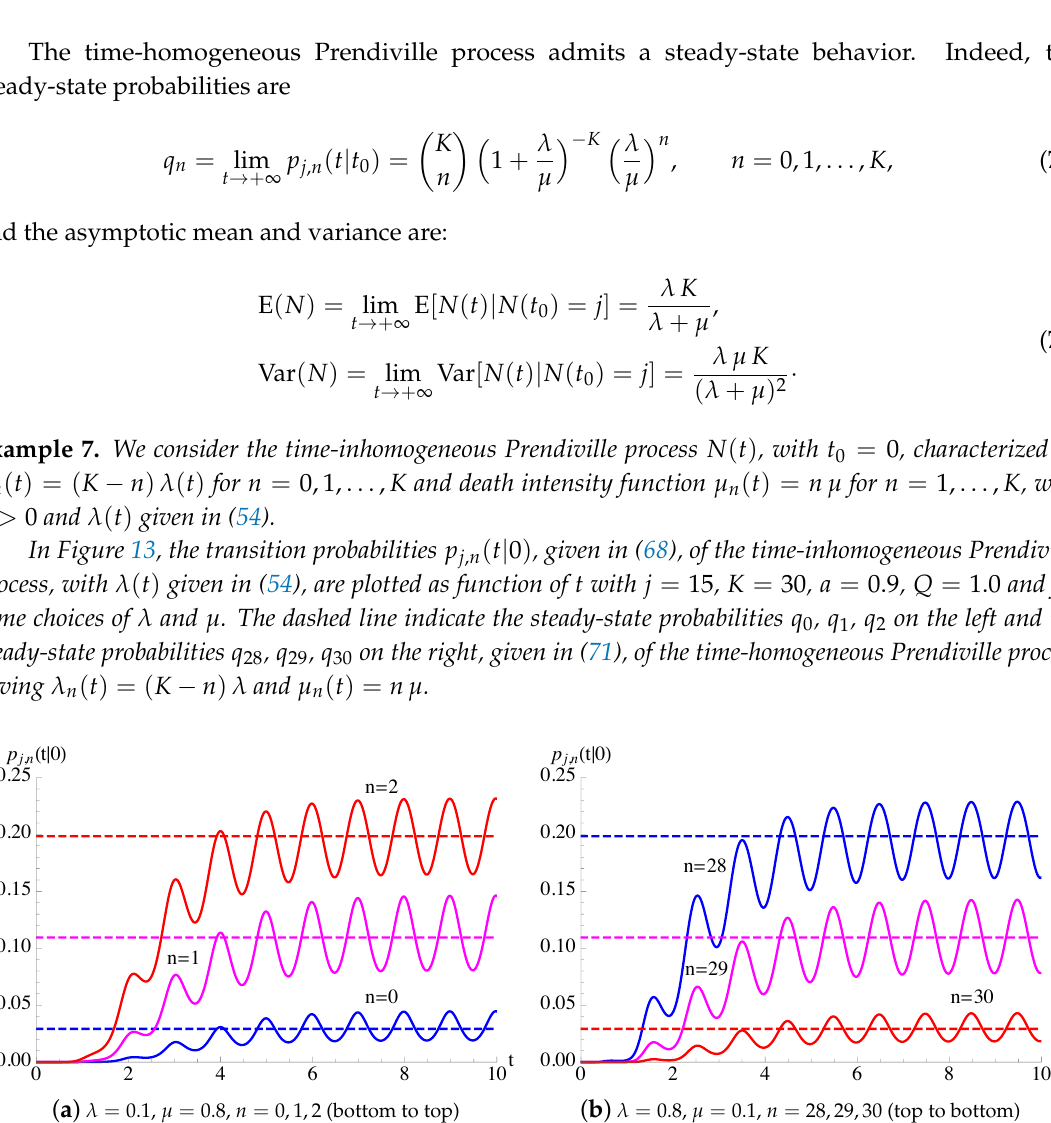
Figure 13. For the Prendiville process, having λ n ( t ) = λ ( t ) ( n + ν ) and µ n ( t ) = µ n , with λ ( t ) given in (54), the probabilities p j , n ( t | 0 ) are plotted as function of t with j = 15, K = 30, a = 0.9, Q = 1.0 and for some choices of λ and µ